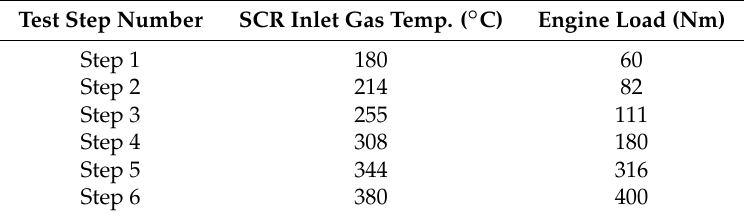
Figure 2. Results of NH 3 and CO 2 concentration measured over urea–water solution heat ‐ up.